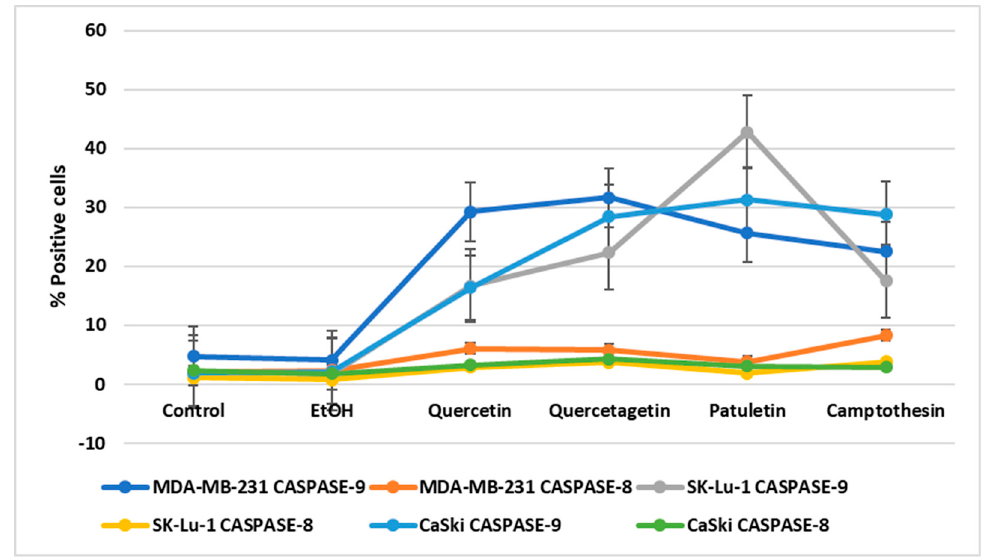
Figure 11. Percentage of positive cells to active caspase-8 and caspase-9 treated with quercetin, quercetagetin, and patuletin.